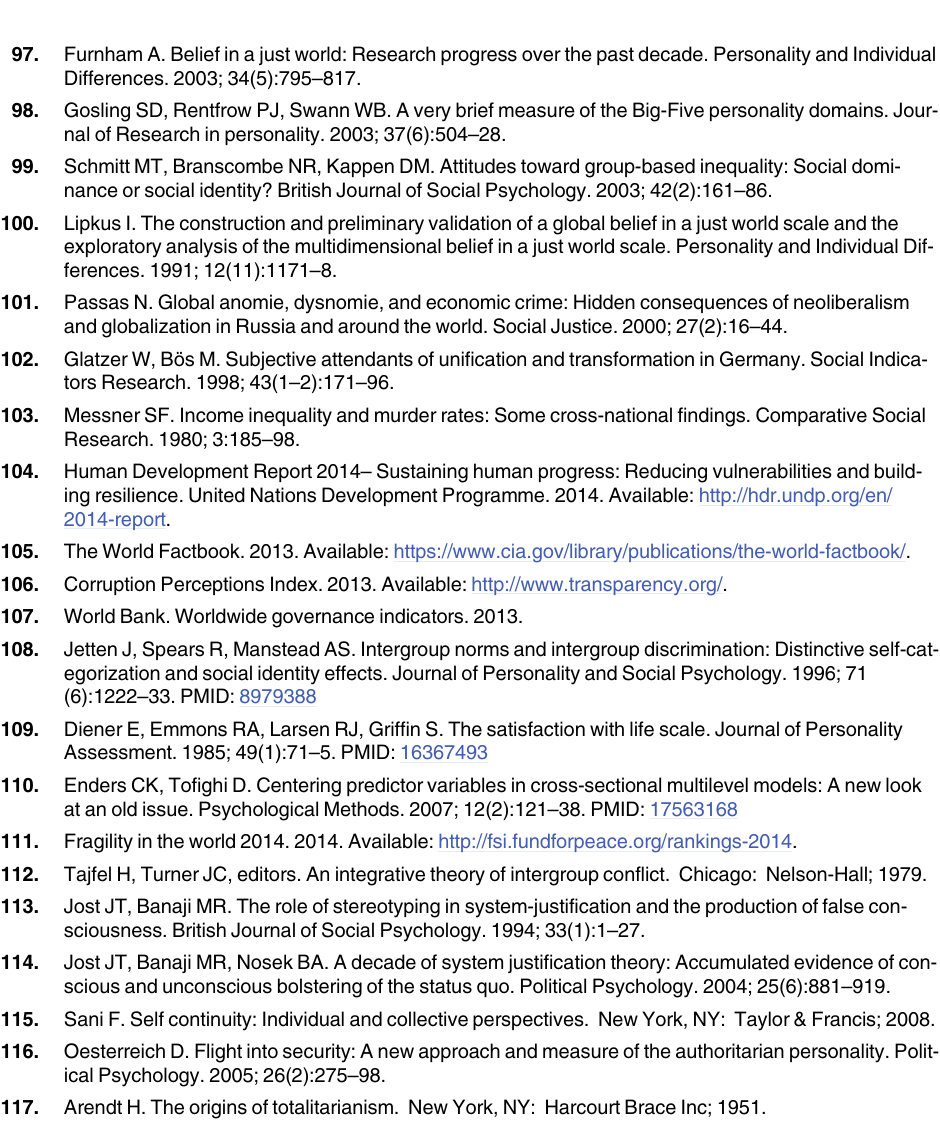
PLOS ONE | DOI:10.1371/journal.pone.0158370 July 6,